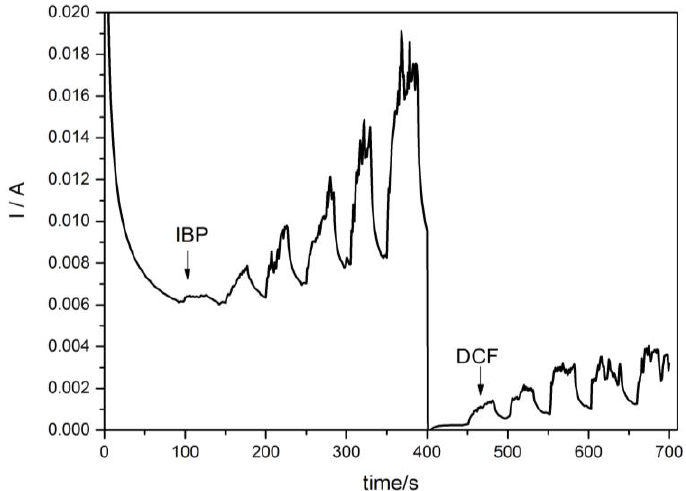
Figure 6. Amperometric response at the HKUST-CNF electrode for the six successive and continuous additions of 2 mg · L − 1 IBP recorded at +1.25 V vs. SCE for 400 s running time followed by the five successive and continuous additions of 2 mg · L − 1 DCF at applied potential of +0.8 V vs. SCE for the next running time of 400 s.